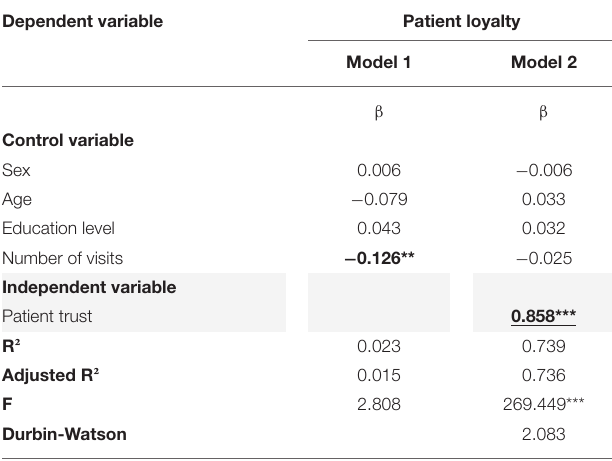
TABLE 10 | Trust and customer loyalty regression analysis ( n = 483).